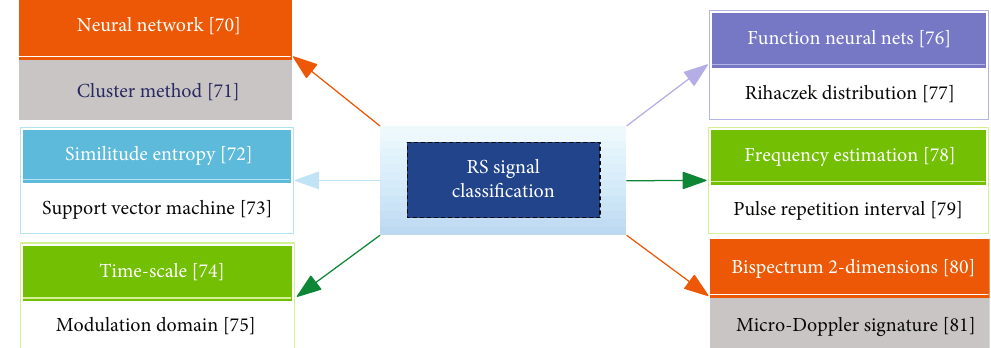
Figure 8: Radar signal classi fi cation mode.